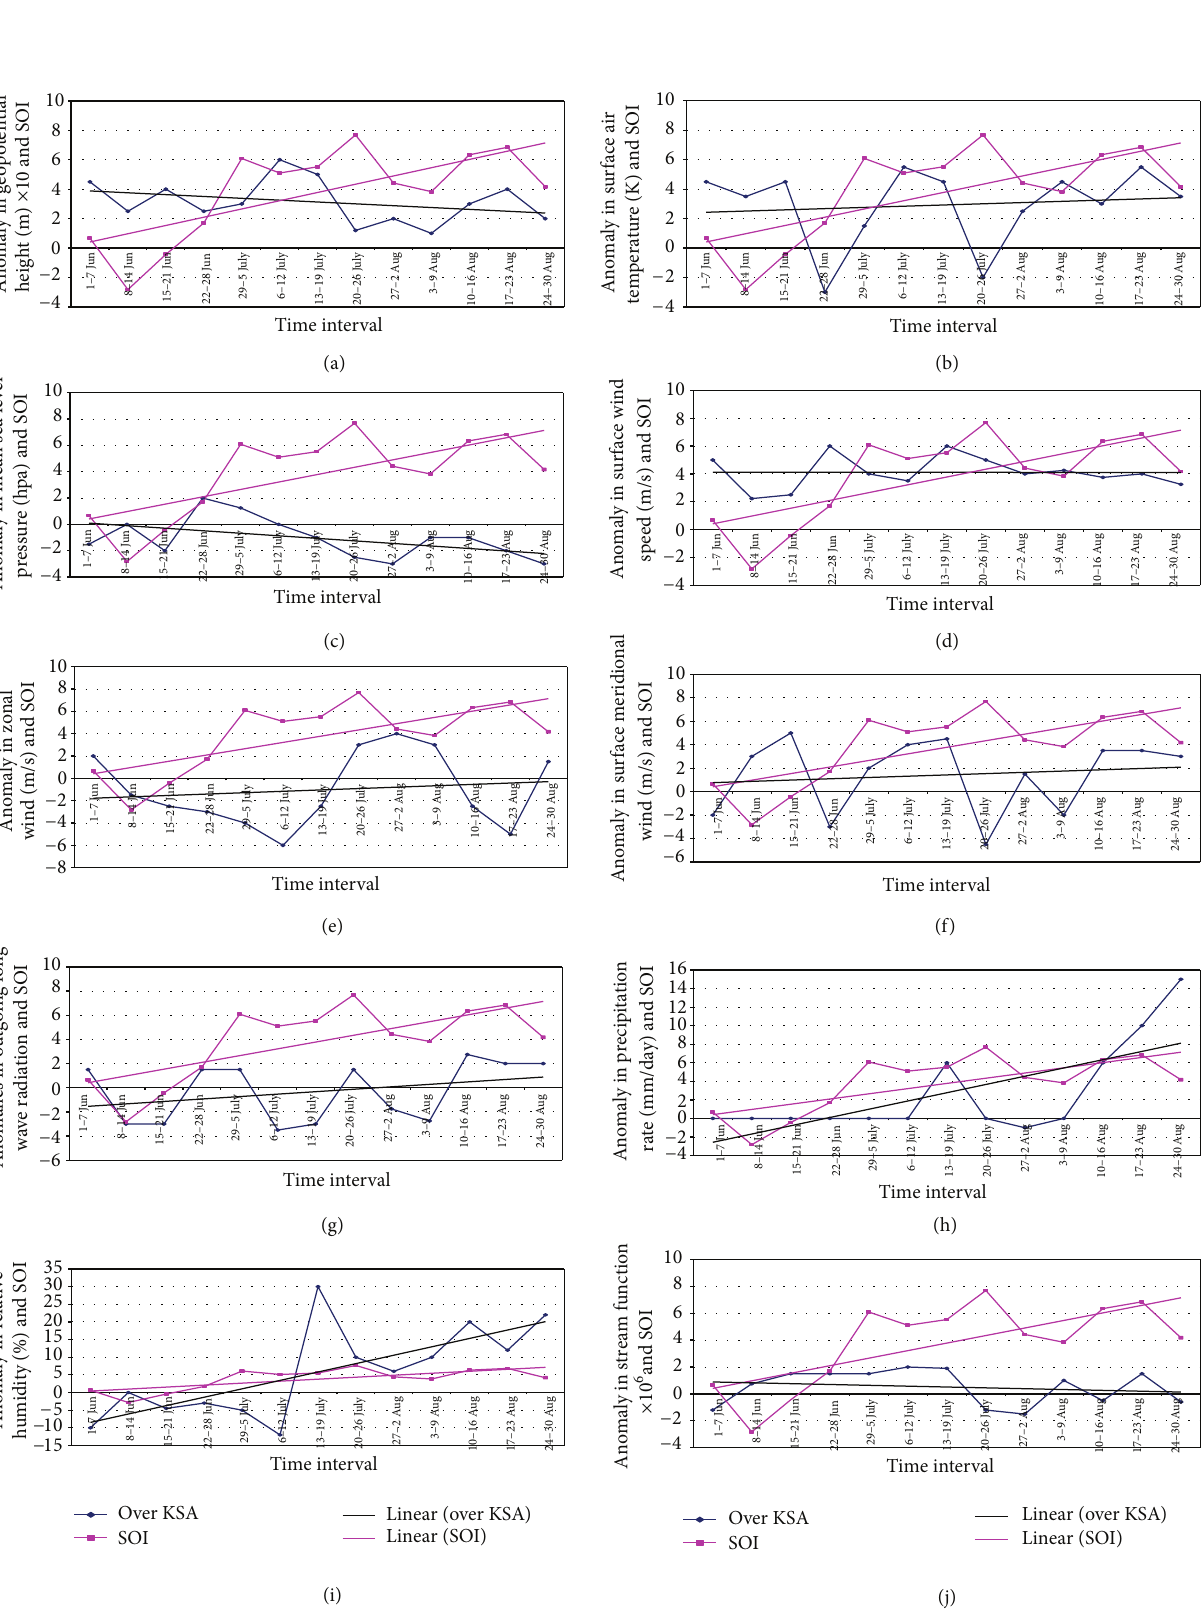
Figure 9: Time series analysis—7 days—of anomaly of the SOI and anomaly of weather elements over KSA during the summer season